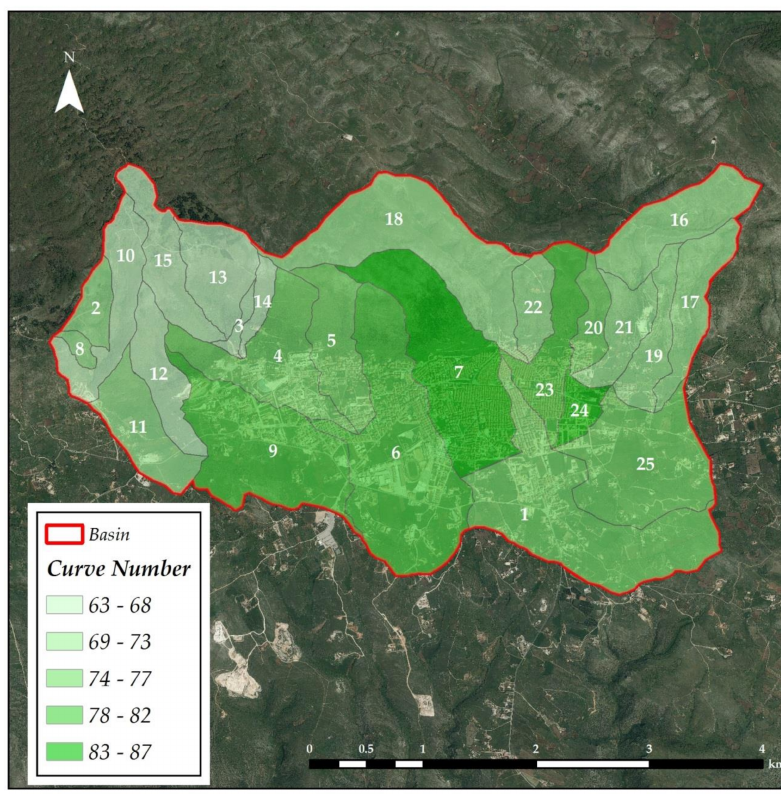
Figure 4. Curve number